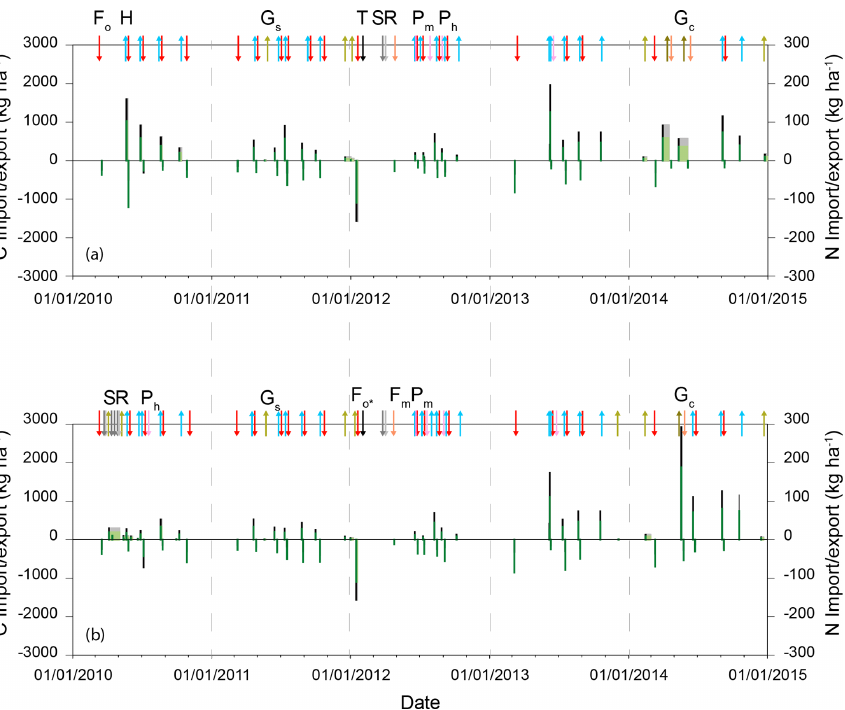
Figure 2. Management activities for both parcels (A and B in panels a and b , respectively) on the CH-Cha site. Overall management varied particularly in 2010 between both parcels, whereas similar management took place between 2011 and 2014. Arrow direction indicates whether carbon (C in kgha − 1 ) and/or nitrogen (N in kgha − 1 ) was amended to or exported from the site ( F o and F o ∗ – organic fertilizers, slurry and manure (red); F m – mineral fertilizer (light orange); H - harvest (light blue); G s and G c – grazing with sheep and cows, respectively (light and dark brown)). Other colored arrows visualize any other management activities such as pesticide application ( P h – herbicide (light pink); P m – molluscicide (dark pink); T – tillage (black), R – rolling (light grey) and S – sowing (dark grey)) which occurred predominantly in 2010 (parcel B) and 2012 (parcels A and B). Carbon imports and exports are indicated by black and grey bars. Thereof black indicates the start of the specific management activities and grey the duration (e.g., during grazing, G s ). Green colors indicate nitrogen amendments or losses, with dark green visualizing the start of the activity and light green colors indicating the duration. Sign convention: positive values denote export or release and negative values import or